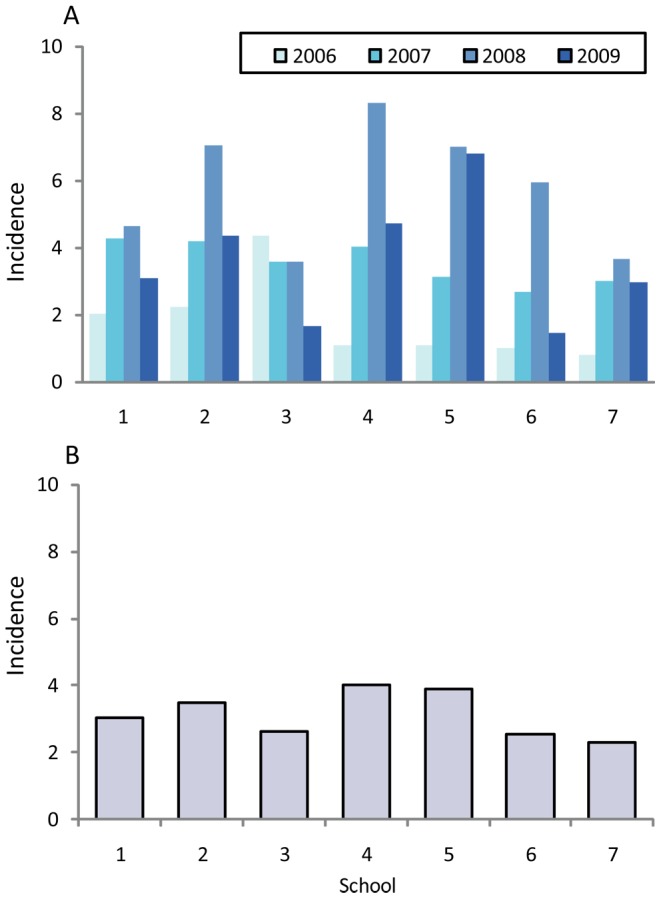
Dengue incidence.(A) Shown is the incidence by school in each year. (B) Shown is the incidence by school in all years.